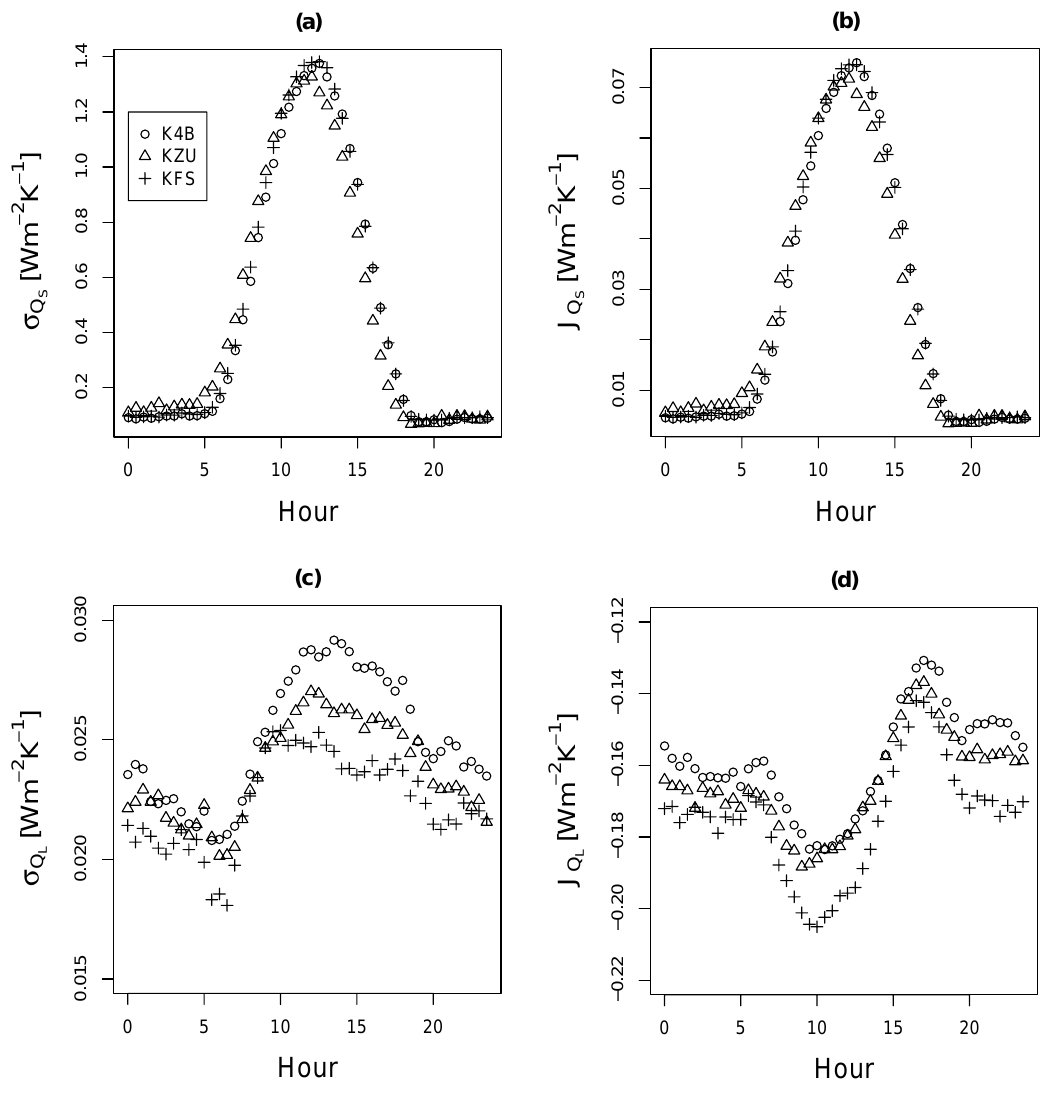
Fig. 10. Mean diurnal entropy terms associated with (a) production due to to conversion of shortwave radiant energy, (b) transport due to shortwave radiation (c) production due to longwave radiant exchange and (d) transport associated with longwave radiation computed from the eddy covariance